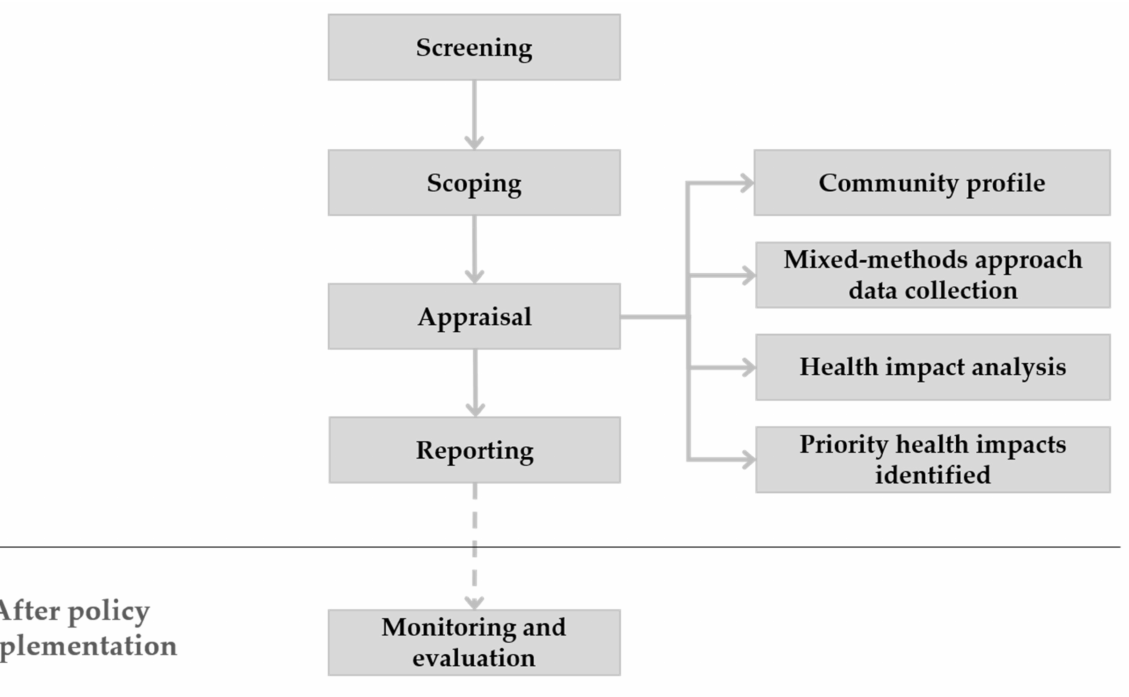
Figure 1. Stages of health impact assessment (HIA)